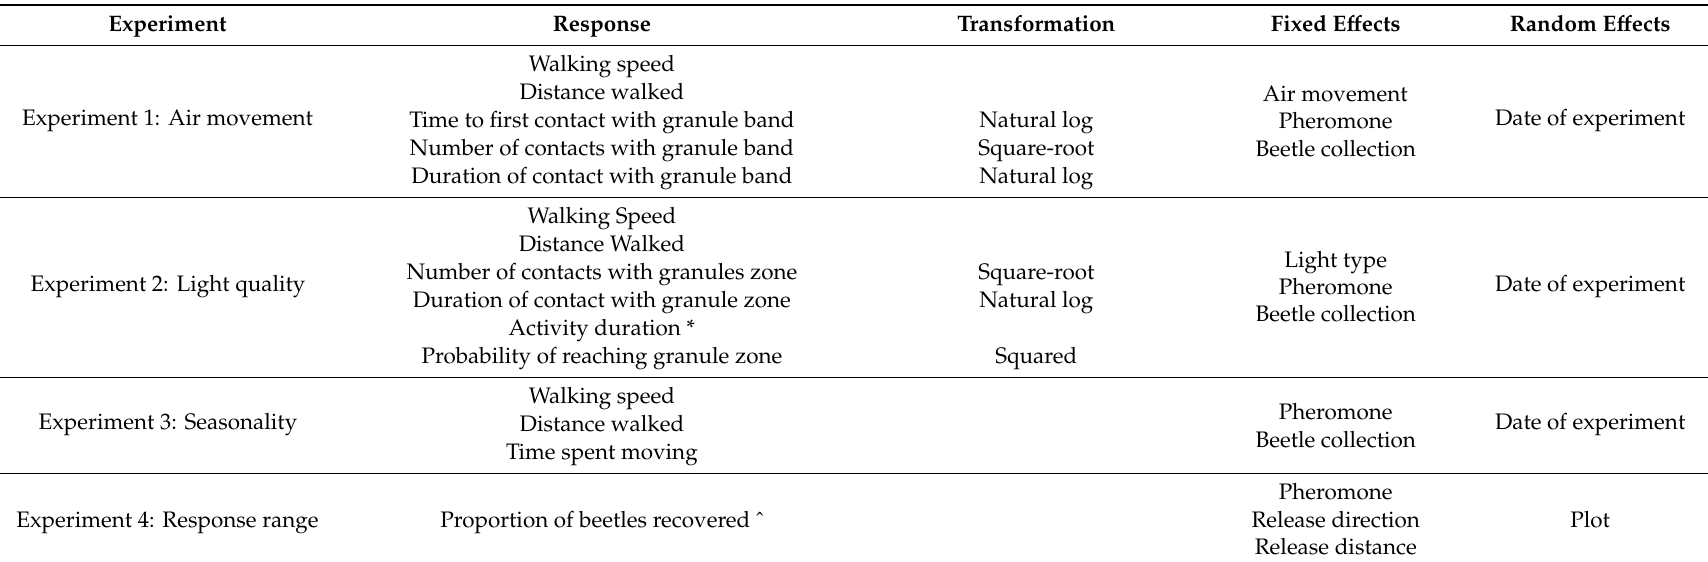
Table 1. Model specification. A linear mixed model was used, unless otherwise